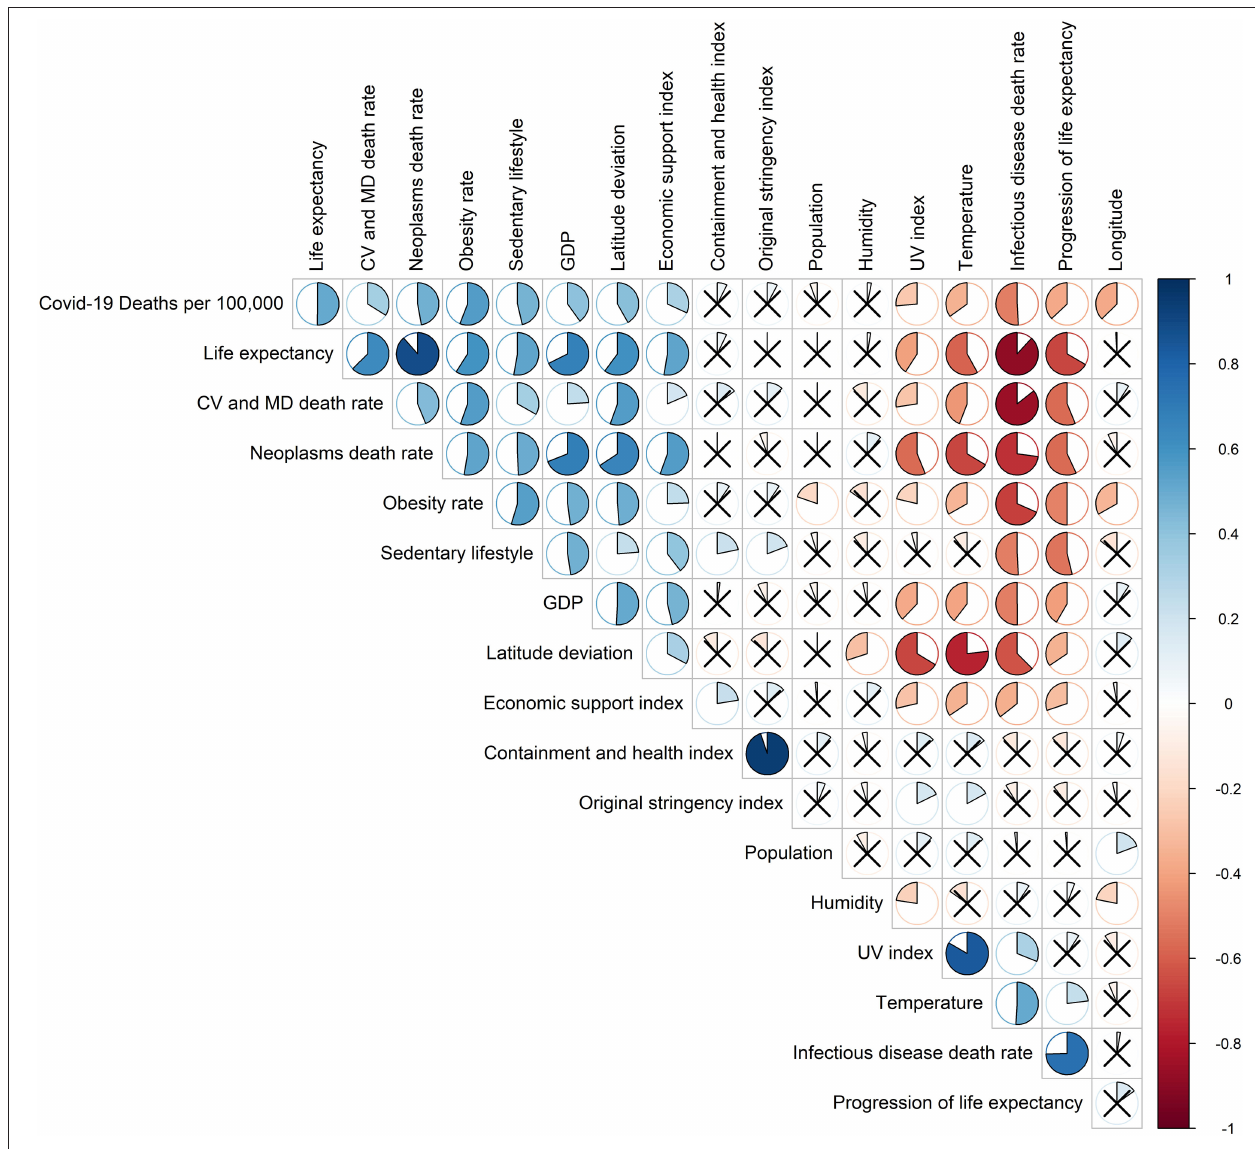
FIGURE 6 | Correlation matrix: a larger area in the circles indicates a stronger correlation between the row and the column variables. A blue circle indicates a positive correlation coefficient; a red circle indicates a negative one; a full circle corresponds to r = 1 or − 1; an empty circle corresponds to r = 0. If the Pearson correlation test was not significant, a cross on the circle was